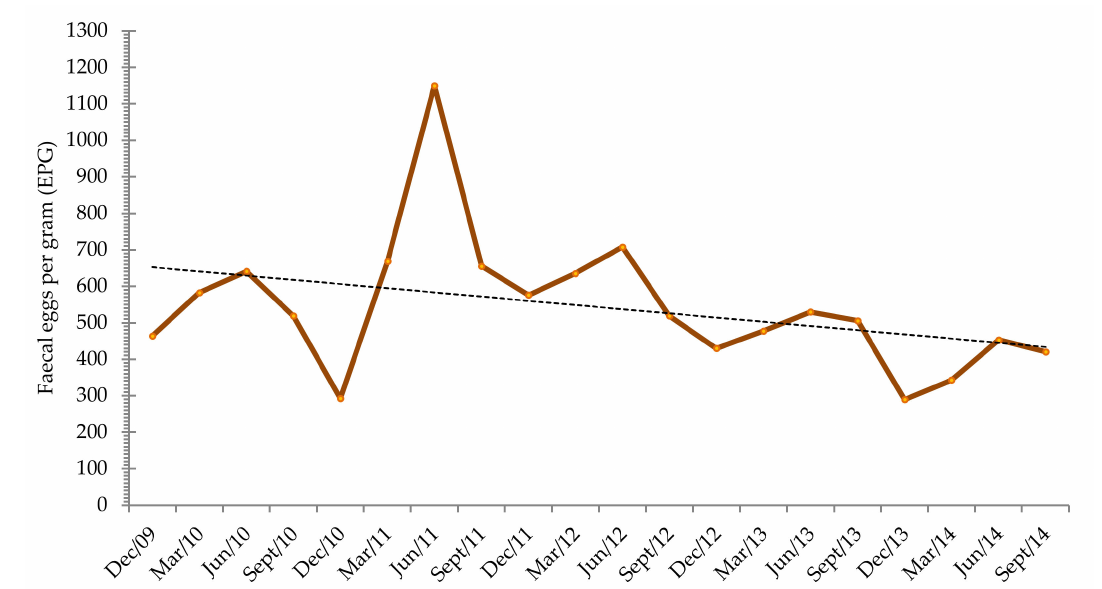
Figure 4. Monthly average of strongyles’ EPG during 2009–2014 and linear trend